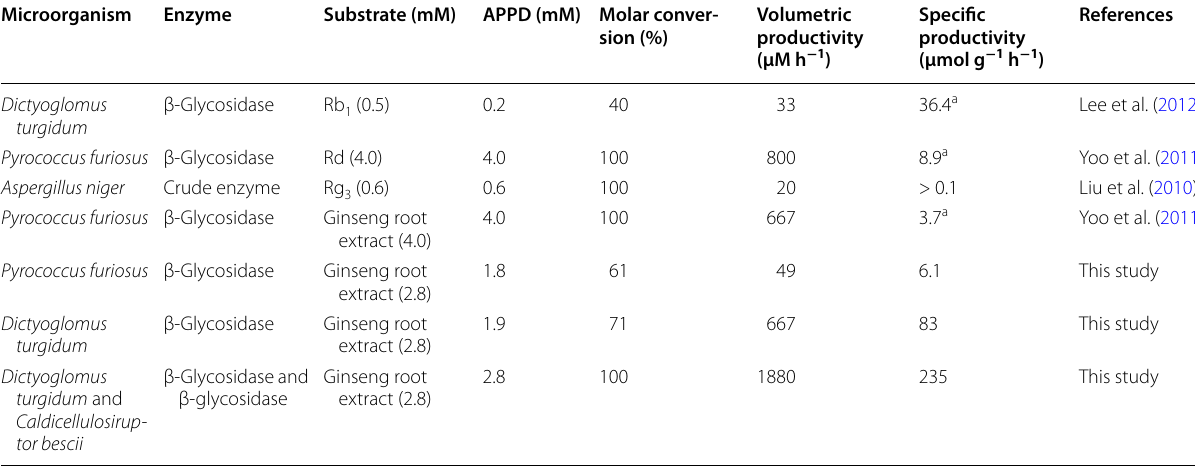
The numbers in parentheses next to the substrates represent the substrate concentration a Represents the calculated values based on the data in the corresponding reference